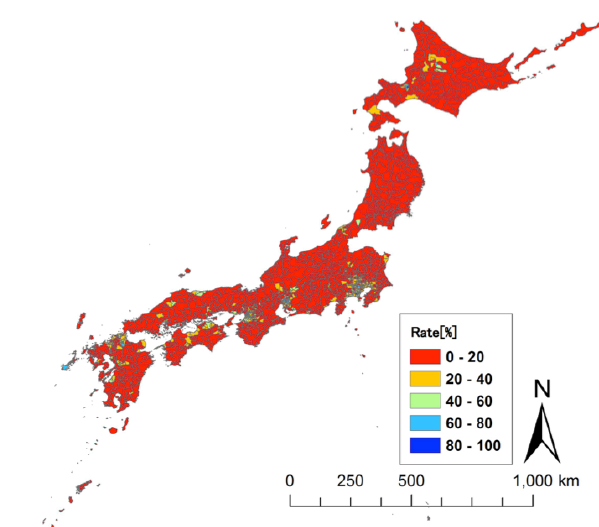
Figure 3. Rates of supermarkets that satisfy the survival conditions in 2040